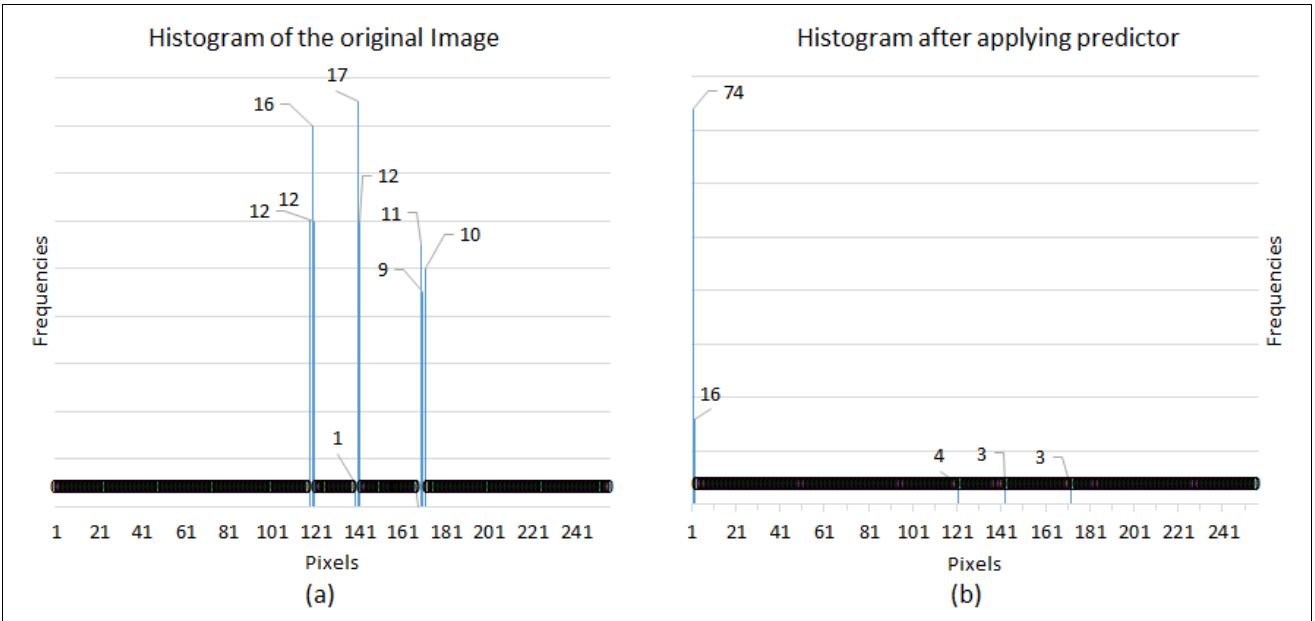
Figure 7. A comparison of histograms before and after application of a